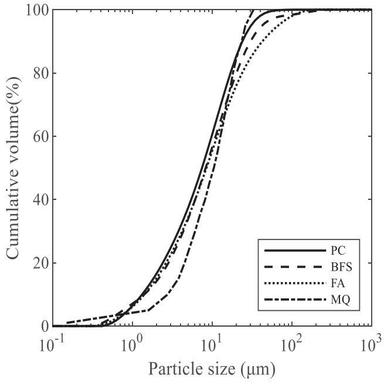
Particle size distribution of raw materials used in this study.